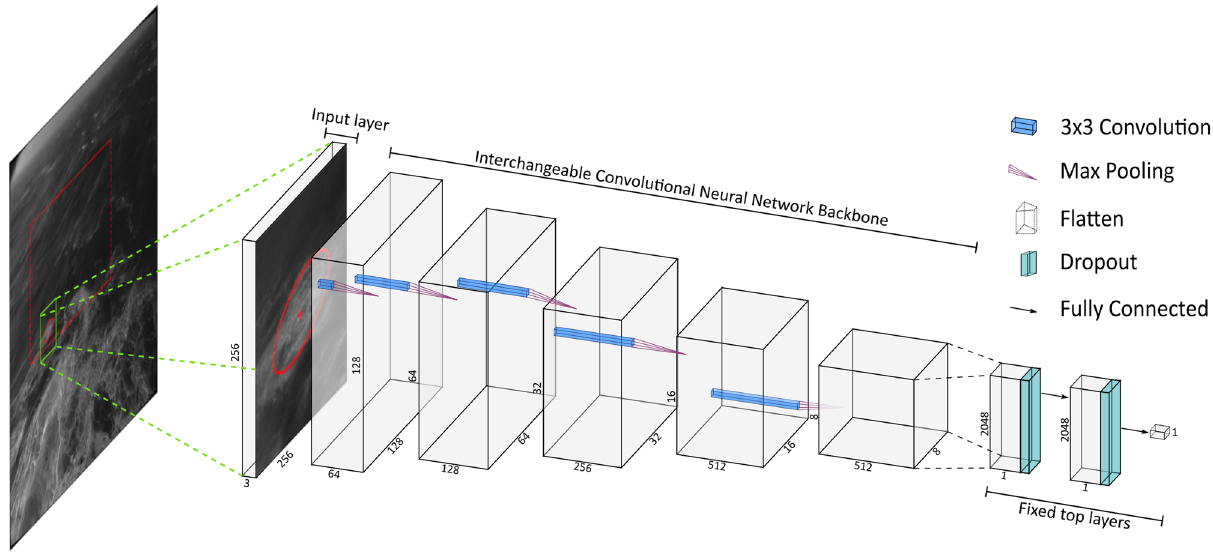
Figure 1. Schematic representation of a deep convolutional neural network. The input layer consists of an active wave breaking candidate and has shape 256 × 256 × 3 (image height, image width and number of RGB channels). In the case of a grey-scale image, the single grey channel was triplicated. The red dashed rectangle in the analyzed image shows the region of interest which, in this particular case, was equal to the stereo video reconstruction area. The intermediary convolutional layers (or backbones) are interchangeable with different options available (see text for details). The function of the convolutional layers is to extract features from the input image by using convolutions ( 3 × 3 in this example) and max pooling 49 (that is, selecting the brightest pixel in a given window). The last convolutional layer is flattened (that is, turned into a one-dimensional vector) and is connected to two fully-connected (that is, multi-layer perceptron-like) layers and one final classification layer. A 50% dropout (that is, random selection of neurons in a layer) is applied after each fully connected layer. The final classification layer has one unit and uses sigmoid activation with a threshold of 0.5.